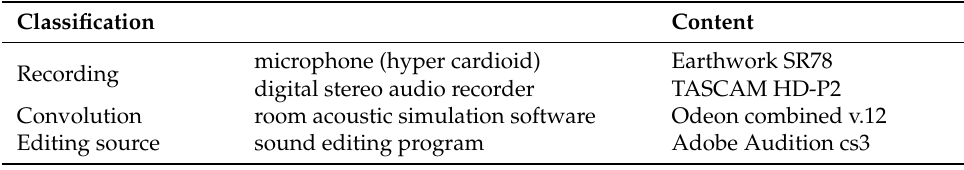
Table 7. Equipment list for producing auralized sound.